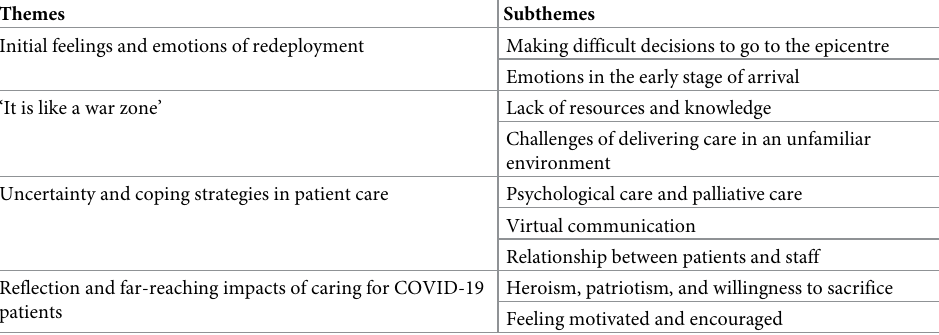
Table 2. Themes and subthemes identified from interviews.